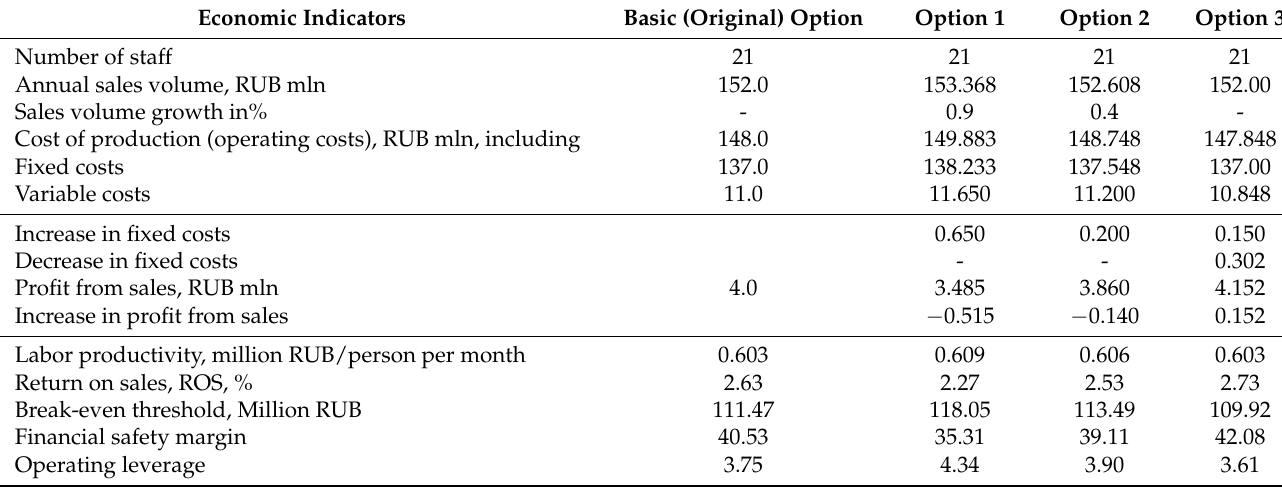
Table 3. The results of the economic assessment of PM (personnel management) projects for a small enterprise.